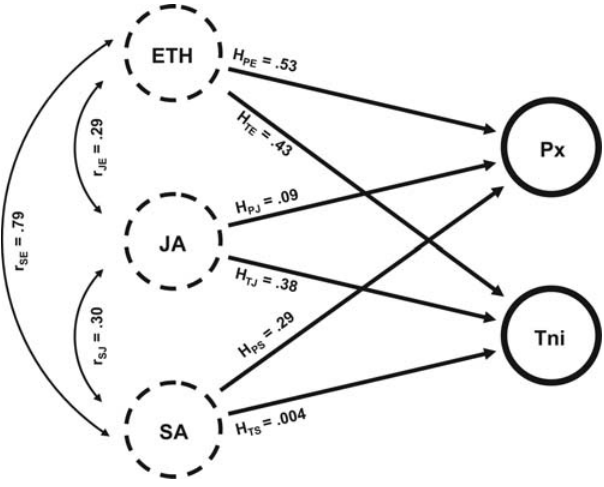
Figure 1. Path Diagram of Insect-Induced Transcriptional Responses. Changes in gene expression which follow wounding or herbivory are causally attributable to the SA, JA, and ethylene regulatory pathways. Three causal variables (ETH, JA, SA; dashed circles) are shown on the left side of the figure, intercorrelated (curved, double headed arrows) due to unknown regulatory and physiological factors (no causal relationship is assumed among these predictor variables). Two response variables (closed circles), DBM (for Plutella xylostella ), and TNI (for Trichoplusia ni ), are shown on the right side of the figure; wounding is not shown to reduce the figure’s complexity. Causal influences are indicated by straight, single headed arrows, which are standardized partial regression coefficients. The input data for these analyses are ratios quantifying induced versus control expression levels at nine hours for the 212 genes showing statistically significant changes in gene